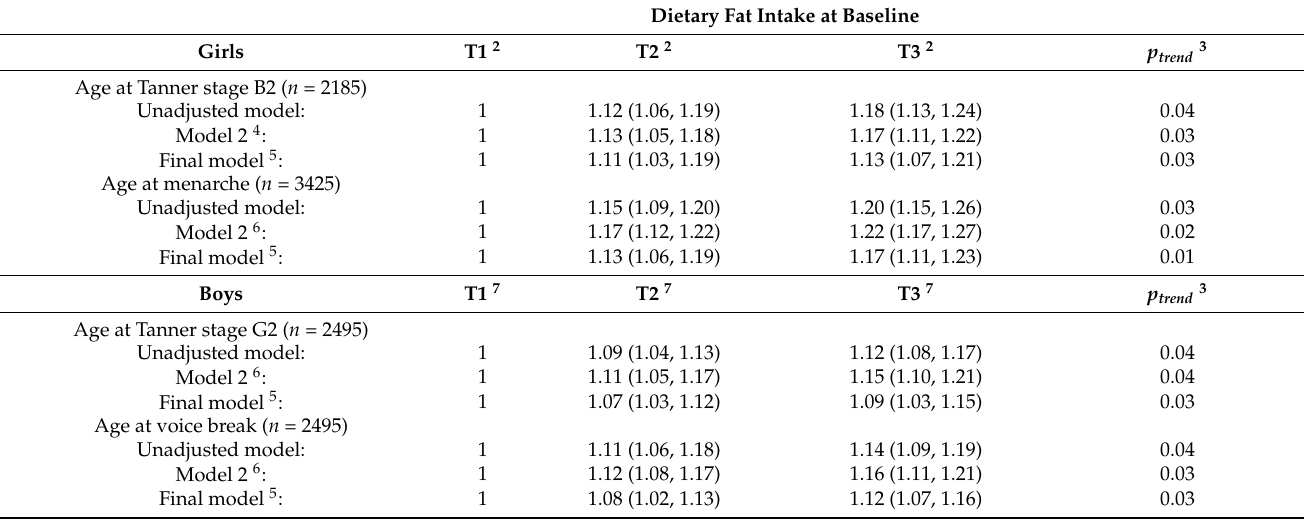
Table 2. Association 1 of dietary fat intake in childhood with puberty timing. Dietary Fat Intake at Baseline